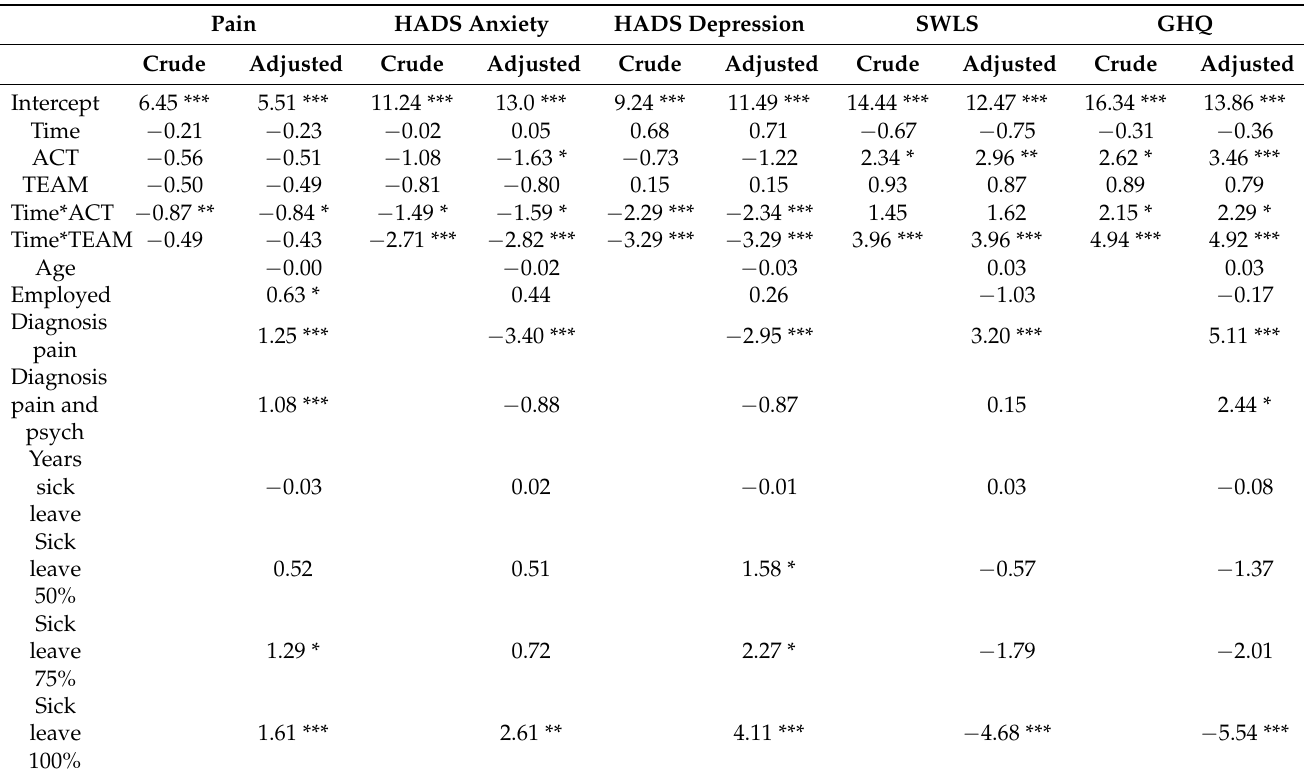
Table 4. Estimates of fixed effects for interaction effects regarding change over time for the experimental groups (time*group) as compared with the reference group Control for the outcome measures. Results from the non-adjusted model are presented as well as the results from the adjusted